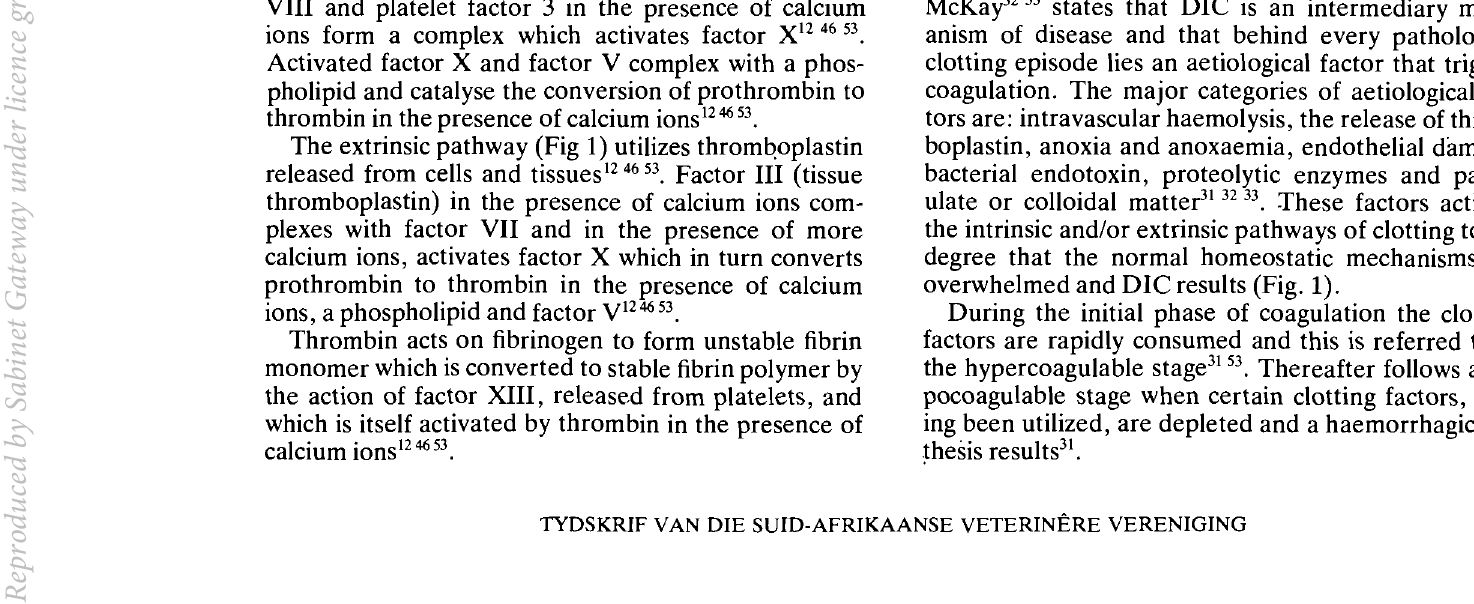
Fig. 1. A schematic summary of the pathogenesis of